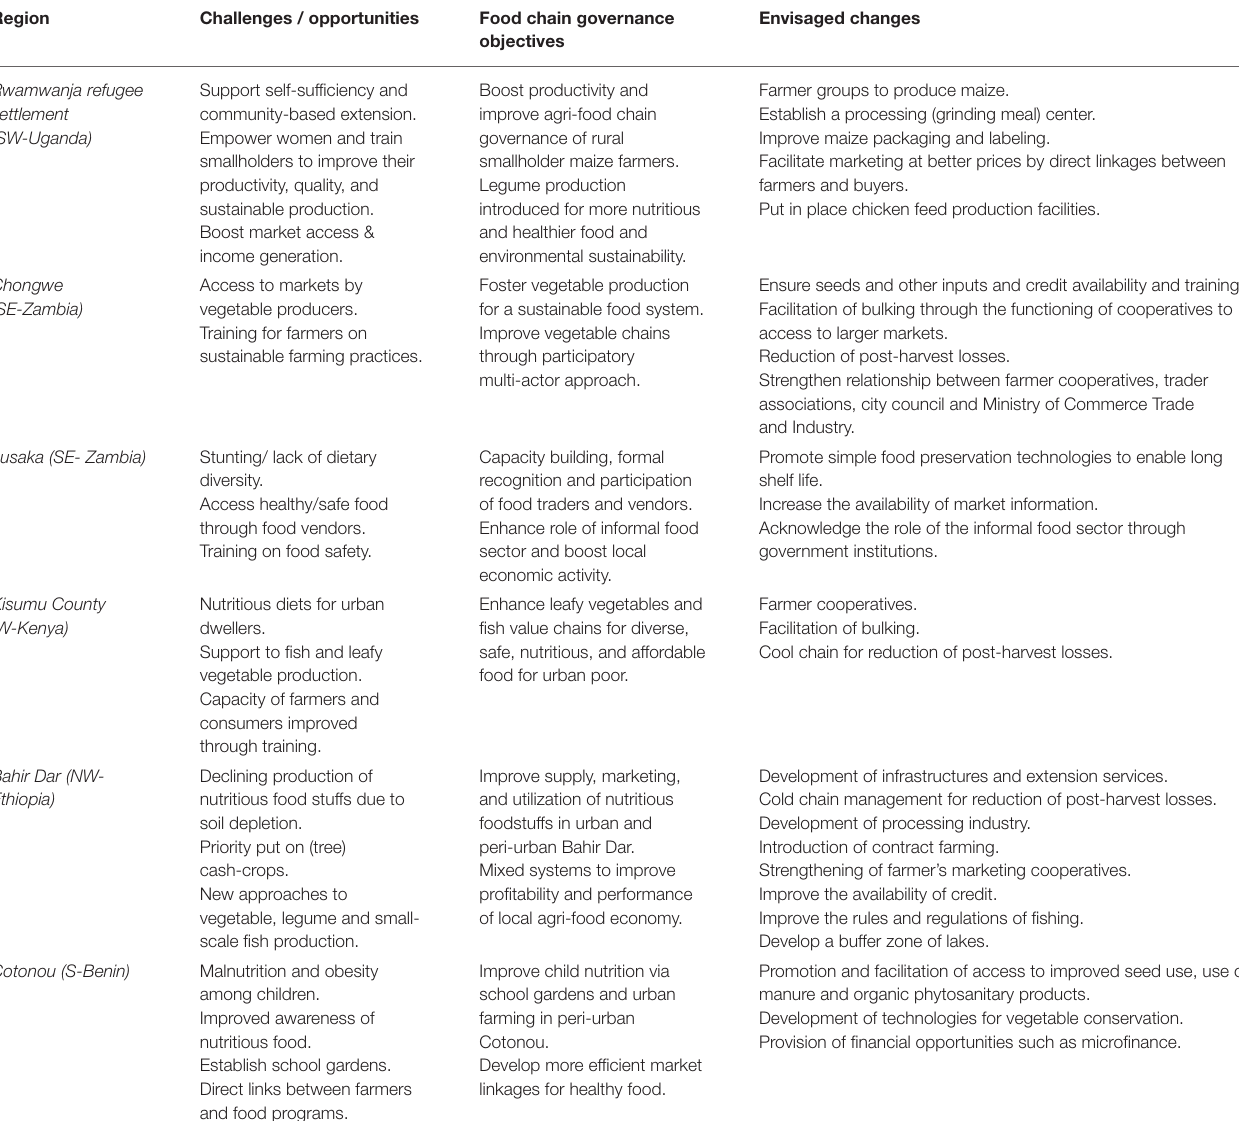
TABLE 5 | Food chain governance challenges, opportunities, objectives and envisaged changes.